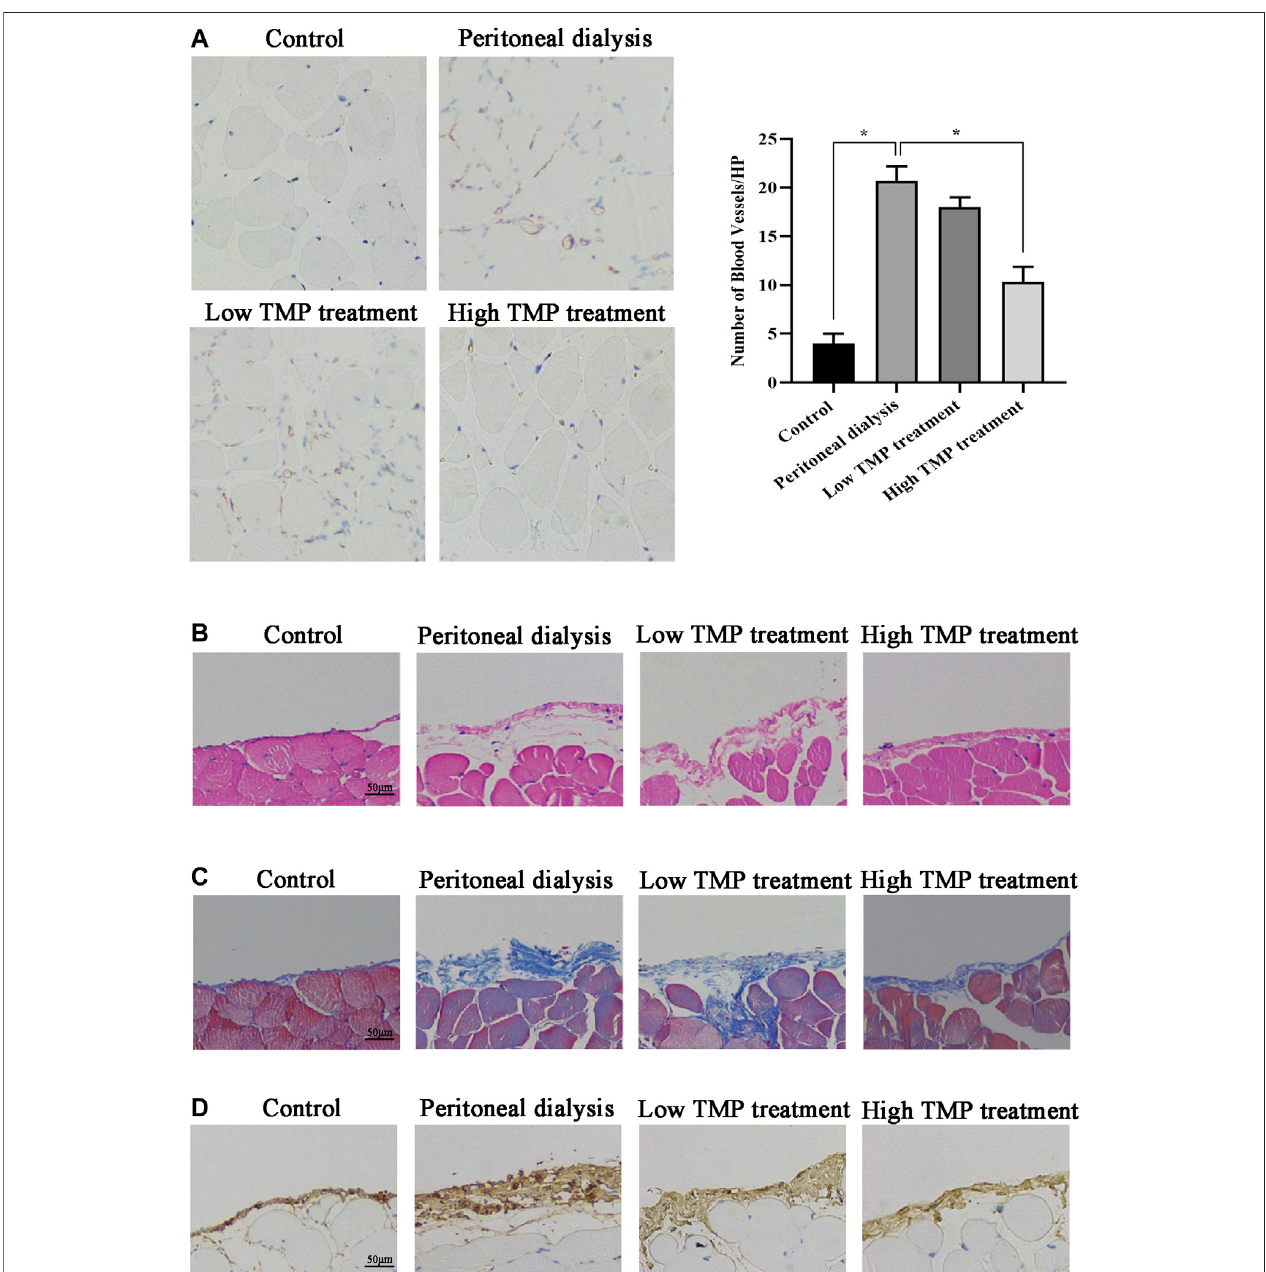
FIGURE 2 | Effect ofTMP on peritoneal angiogenesis and fi brosis in PD mouse. Mice were injected intraperitoneally with PDS, TMP diluted in PDS to form the fi nal concentrations of 40 and 80 nM. (A) Representative fi elds showed the different vessel densities in the parietal peritoneum after immunohistochemistry staining with anticluster of differentiation 31 (CD31) (EC marker) ( × 100). The number of blood vessels per fi eld after anti-CD31 staining, assessed in the peritoneum under × 100 magni fi cation (graph). Data represent mean ± SEM (* p < 0.05). (B) HE staining of mesothelial cells of the parietal peritoneum in mice showed mesothelial injury and fi brosis (scale bar (cid:2) 50 μ m). (C) Peritoneal thickening and ECM deposition were observed using Masson ’ s trichrome staining (scale bar (cid:2) 50 μ m). (D) Tissues of the peritoneum were subjected to immunohistochemical staining for Collagen I expression (scale bar (cid:2) 50 μ m).